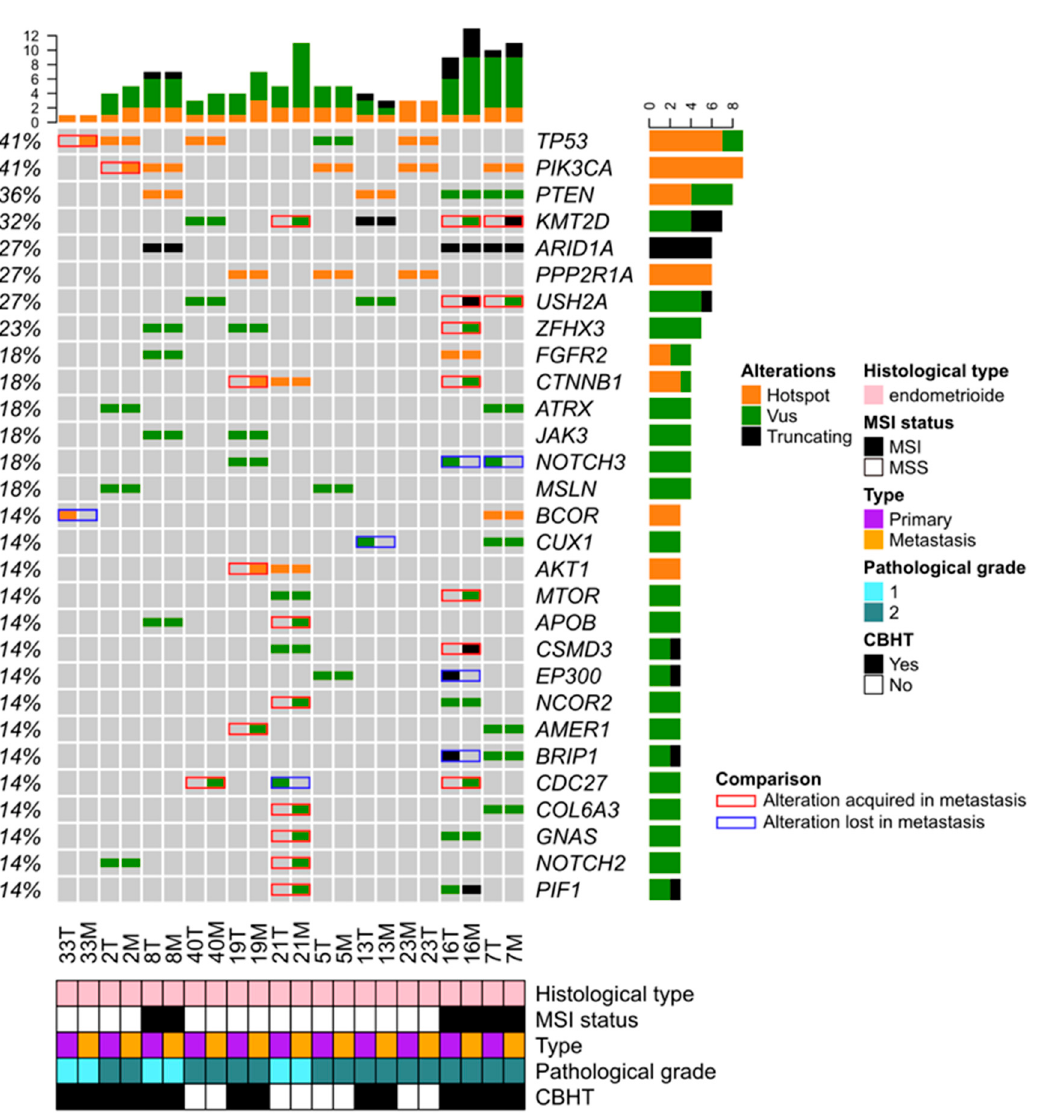
Figure 3. Matched primary and mEC show 22 and 7 mutations acquired and lost in metastatic counterparts, respectively. Legend: green, variant of unknown signification (VUS); orange, hotspot; black, truncating mutation; grey, wild. The right column highlights the difference between the matched samples. Changes over time are coded by: red, mutation gain; green, mutation loss; grey, result not available. Only the 29 most mutated genes are represented.